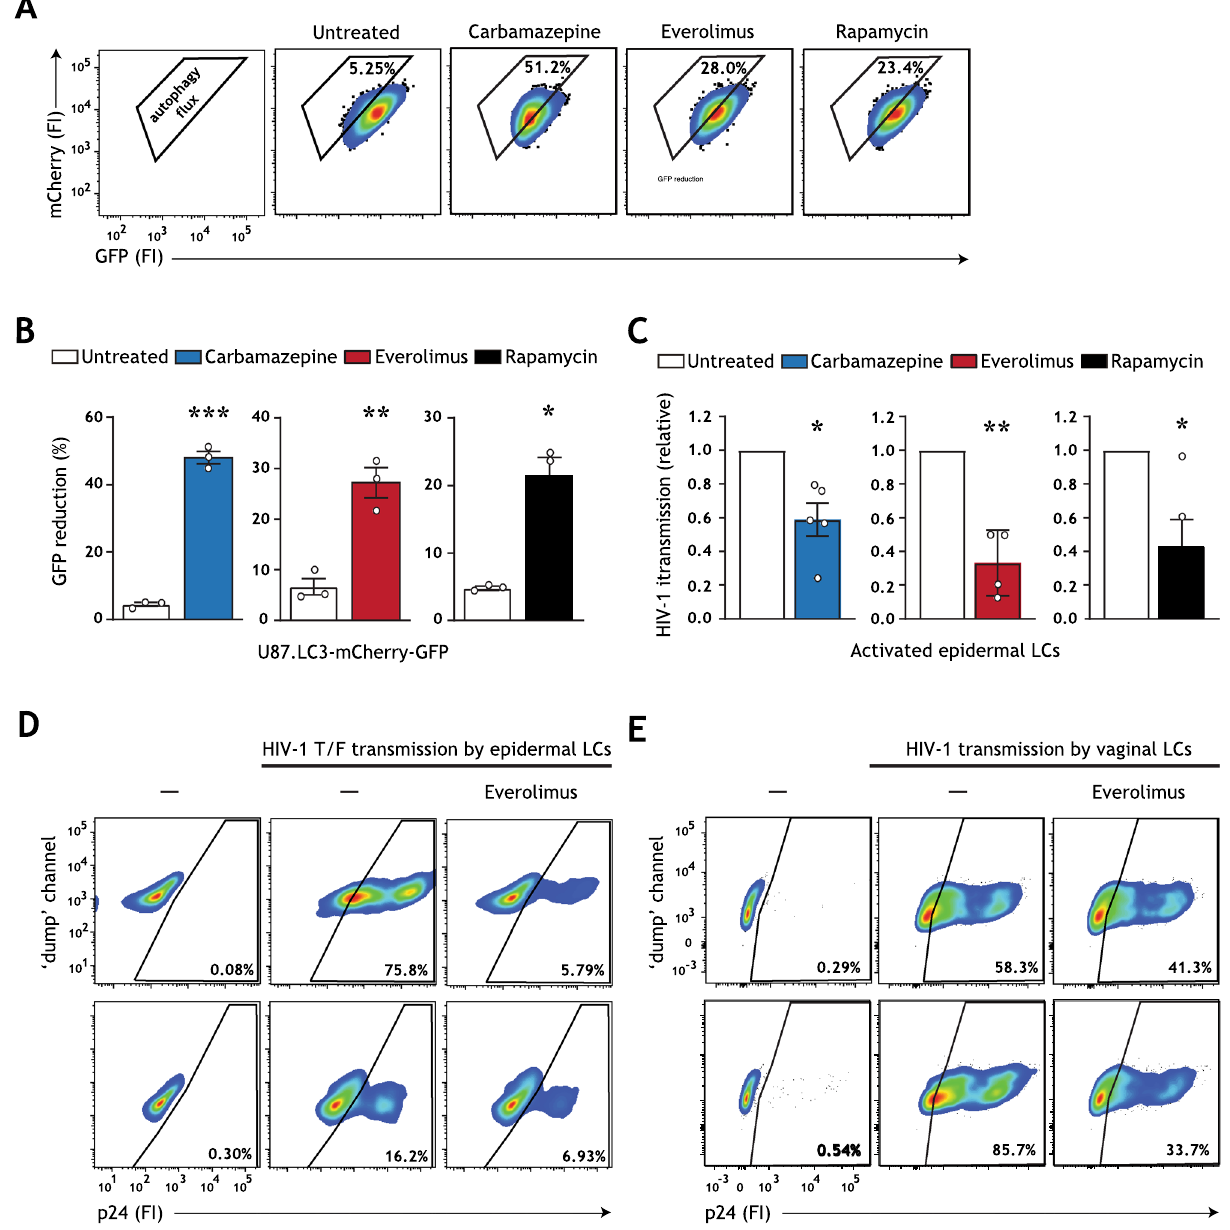
Figure 1. Carbamazepine, everolimus, and rapamycin induce autophagy flux and decrease HIV-1 susceptibility. ( A , B ) U87 cell line expressing tandem fluorescent-tagged LC3 (mCherry-GFP-LC3) was incubated with carbamazepine (1000 μM), everolimus (30 nM), or rapamycin (100 nM) for 48 h. The GFP tag is acid-sensitive and is quenched upon autophagosome acidification. Autophagy flux was determined by the % GFP signal reduction. Representative flow cytometry plots ( A ) and quantification ( B ), data are mean ± SE of n = 3 experiments measured in duplicate. Open circles represent the mean of duplicates from each independent experiment. * P < 0.05, ** P < 0.01, *** P < 0.001, Student’s t test. ( C ) Human epidermal biopsies were prophylactically treated with carbamazepine (100 μM), everolimus (30 nM), or rapamycin (100 nM), or left untreated, and subsequently infected with HIV-1 NL4.3 BaL for 72 h. Emigrated LCs were washed, and co-cultured with U87.CD4.CCR5 cells. HIV-1 transmission by LCs was assessed in LC-U87.CD4. CCR5 co-culture for 72 h, determined by intracellular p24 staining by flow cytometer. LC-marker CD1a was used to exclude single LCs and LC-U87 conjugates from analysis. A detailed graphical depiction of HIV-1 transmission across epidermal tissue is available in Figure S2A, Supplementary Information. Data are mean ± SE of n = 5 experiments measured in duplicate. Open circles represent the mean of duplicates from each independent experiment. * P < 0.05, ** P < 0.01, one-sample t test. ( D ) Human epidermal biopsies were pre-treated with everolimus (30 nM), followed by infection with transmitted/founder HIV-1 THRO for 72 h. Emigrated LCs were washed, and co-cultured with U87.CD4.CCR5 cells. HIV-1 transmission by LCs was assessed in LC-U87.CD4.CCR5 co-culture for 72 h, determined by intracellular p24 staining by flow cytometer. LC-marker CD1a was used to exclude single LCs and LC-U87 conjugates from analysis. Flow cytometry plots of HIV-1 infection of U87.CD4.CCR5 cells for each epidermal tissue donor is shown. ( E ) Isolated human immature vaginal LCs, obtained by CD1a magnetic cell isolation, were pre-treated with everolimus (30 nM) and subsequently infected with HIV-1 NL4-3 BaL for 72 h. Vaginal LCs were washed, and co-cultured with U87.CD4.CCR5 cells. HIV-1 transmission by LCs was assessed in LC-U87.CD4.CCR5 co-culture for 72 h, determined by intracellular p24 staining by flow cytometer. LC-marker CD1a was used to exclude single LCs and LC-U87 conjugates from analysis. Flow cytometry plots of HIV-1 infection of U87.CD4.CCR5 cells for each vaginal LC donor is